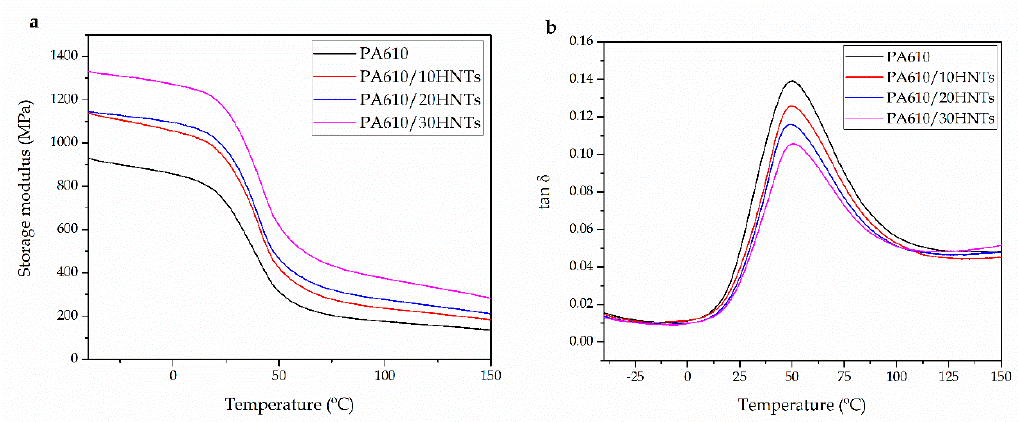
Figure 5. ( a ) Storage modulus (E’) and ( b ) dynamic damping factor (tan δ ) of polyamide 610 (PA610) composites with di ff erent HNTs loading.